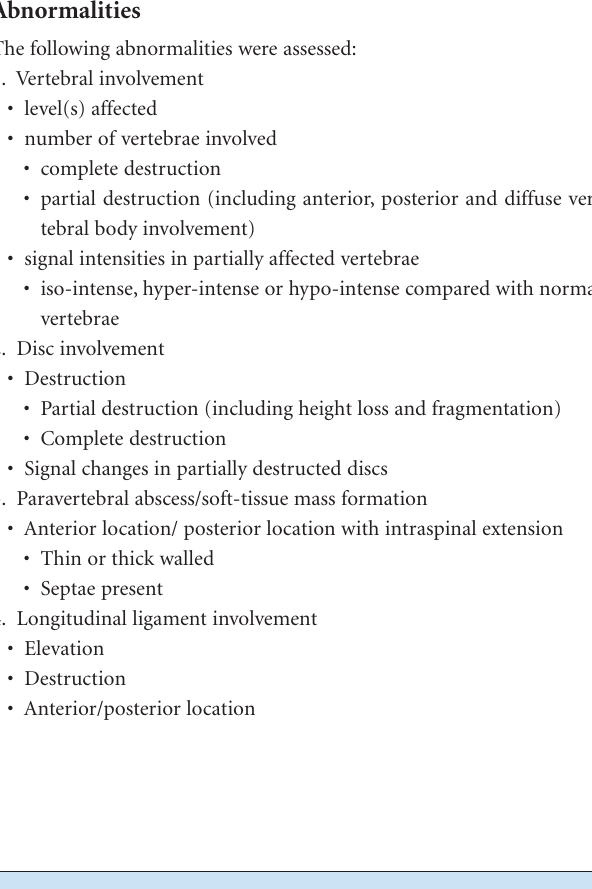
Table I. Level of epicentre of vertebral